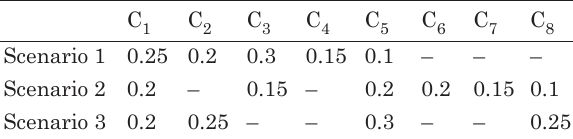
Table 14. Weights of criteria based on the scenarios